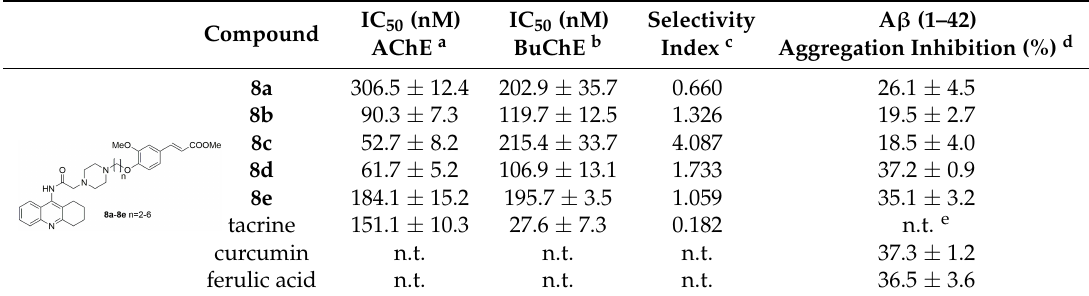
Table 1. Inhibition of ChEs activity and self-induced A β (1–42) aggregation.